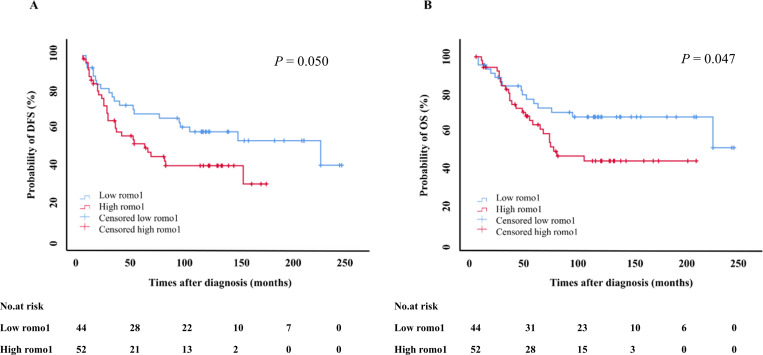
Kaplan–Meier survival curves for disease free survival (DFS) (A) and overall survival (OS) (B) in the overall population. P-values were determined using the log-rank test. romo1, reactive oxygen species modulator 1.